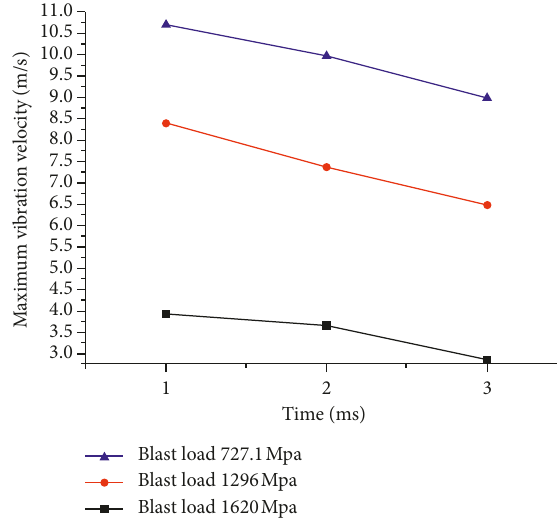
Figure 12: Maximum vibration velocity attenuation under dif- ferent blasting loads within 1 ∼